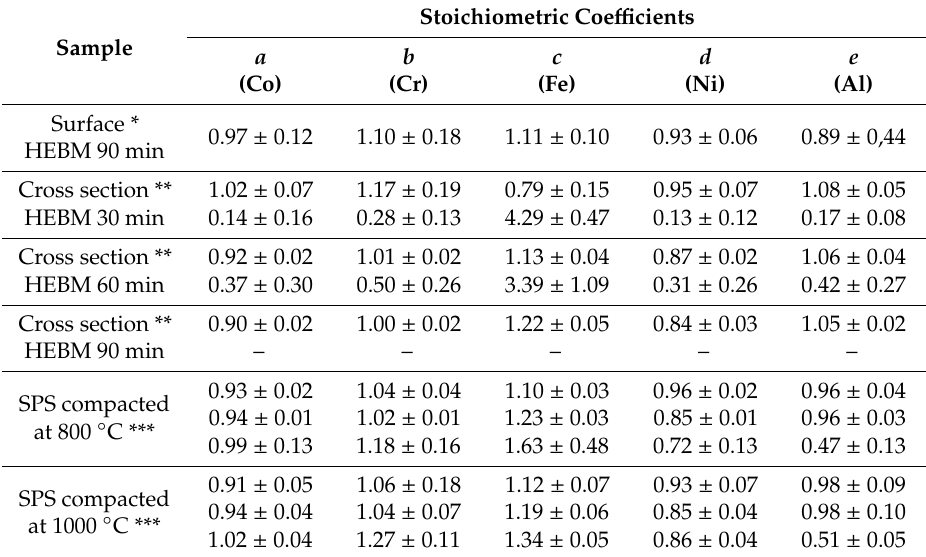
Table 1. EDS results for the surface and cross section of alloyed powder particles for bulk materials formed upon SPS-consolidation.